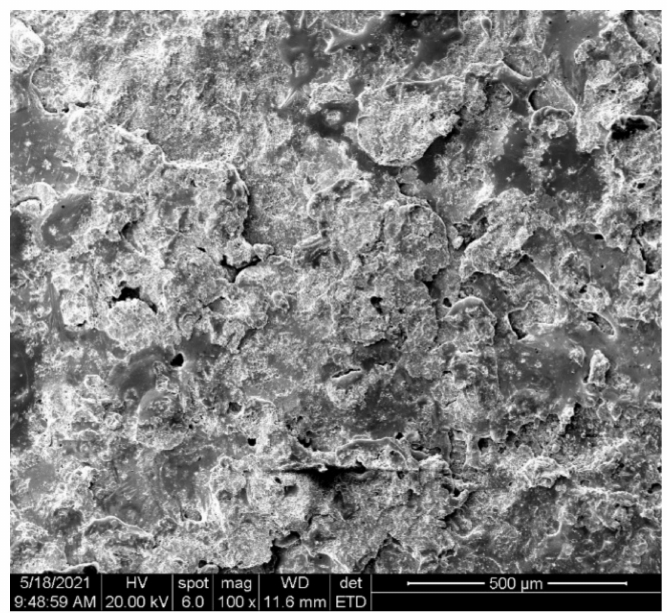
Figure 2. The morphology of the running-in coating surface of specimen 2.